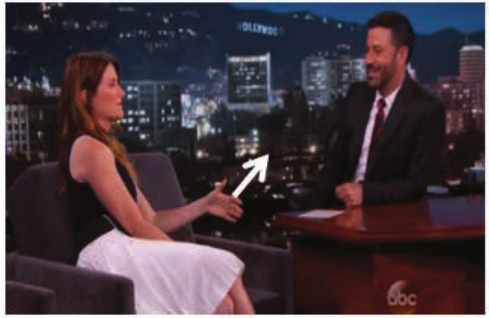
Figure 2. Gesture with My mom opened the door